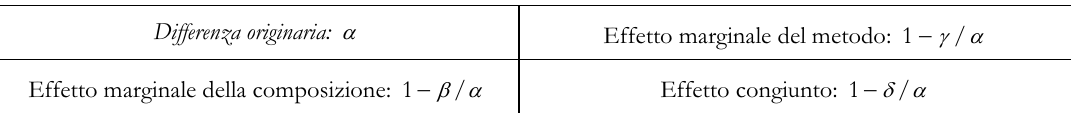
Figura 3 – Schema di decomposizione della differenza originaria (cid:68) fra misure ‘grezze’ di mobilità dei lavoratori da INPS e RTFL